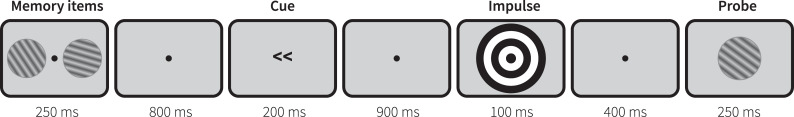
The retro-cue delayed-response task.After the presentation of the memory items, a cue indicates which grating needs to be maintained in WM for judgement of the probe. Decodable EEG activity is elicited by the task-neutral impulse, which is presented between the cue and the probe.